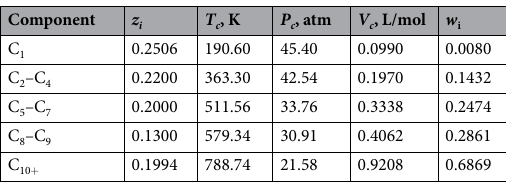
Table 1. Compositions and basic properties of the fluid.